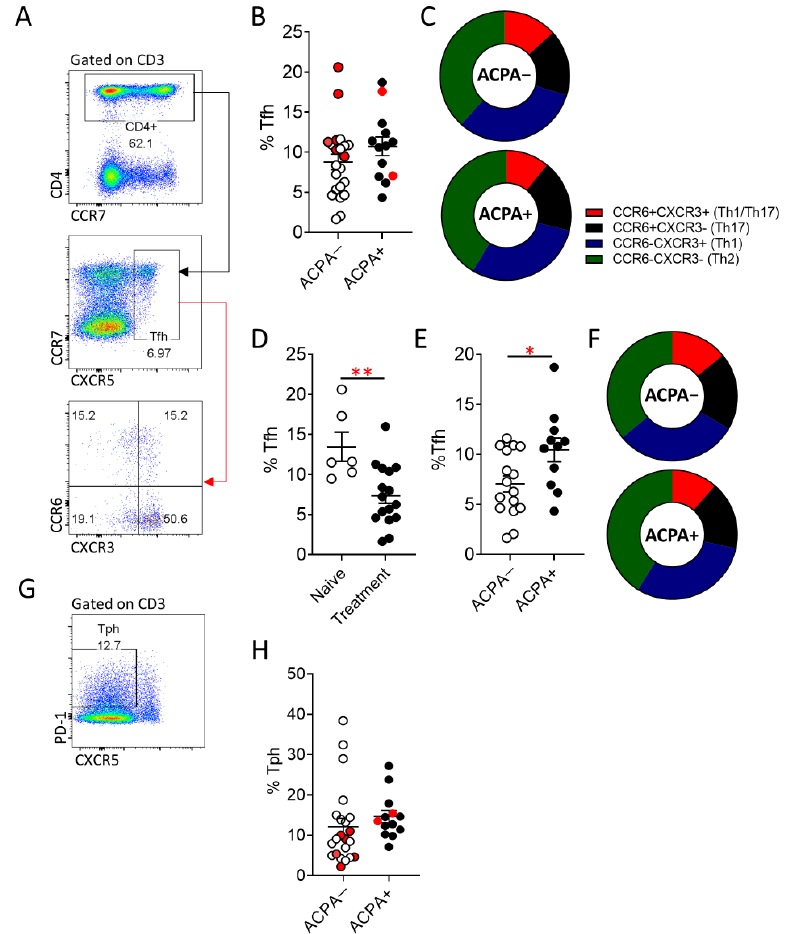
Figure 3. Increased Tfh cell frequency in ACPA + compared to ACPA− RA patients undergoing treatment. ( A ) Representative flow cytometric analysis for the identification of Tfh cells (CXCR5 + CD4 + ) and subsequent characterisation of CCR6 + CXCR3 + (Th1/Th17-like Tfh), CCR6 + CXCR3 − (Th17-like Tfh), CCR6 − CXCR3 + (Th1-like Tfh) and CCR6 − CXCR3 − (Th2 like Tfh), cells. ( B ) Cumulative data on the Tfh cell frequency of APCA − and APCA+ RA patients, samples in red indicate treatment naïve patients. ( C ) Tfh distribution to the indicated subpopulations. ( D ) Frequency of Tfh cells in treatment naïve compared to treated ACPA − RA patients. ( E , F ) comparison of total Tfh and subpopulation distribution between ACPA − and ACPA+ RA patients following exclusion of naïve to treatment patients. ( G , H ) Representative flow cytometric analysis for the identification of Tph cells (CD4 + PD-1 + CXCR5 − ) and peripheral blood Tph frequency of ACPA − and ACPA+ RA patients. Data are presented as mean ± SEM, symbols represent individual samples. Statistical analysis was performed by using two-tailed Mann-Whitney test, p < 0.05 * were considered significant, ( p < 0.01